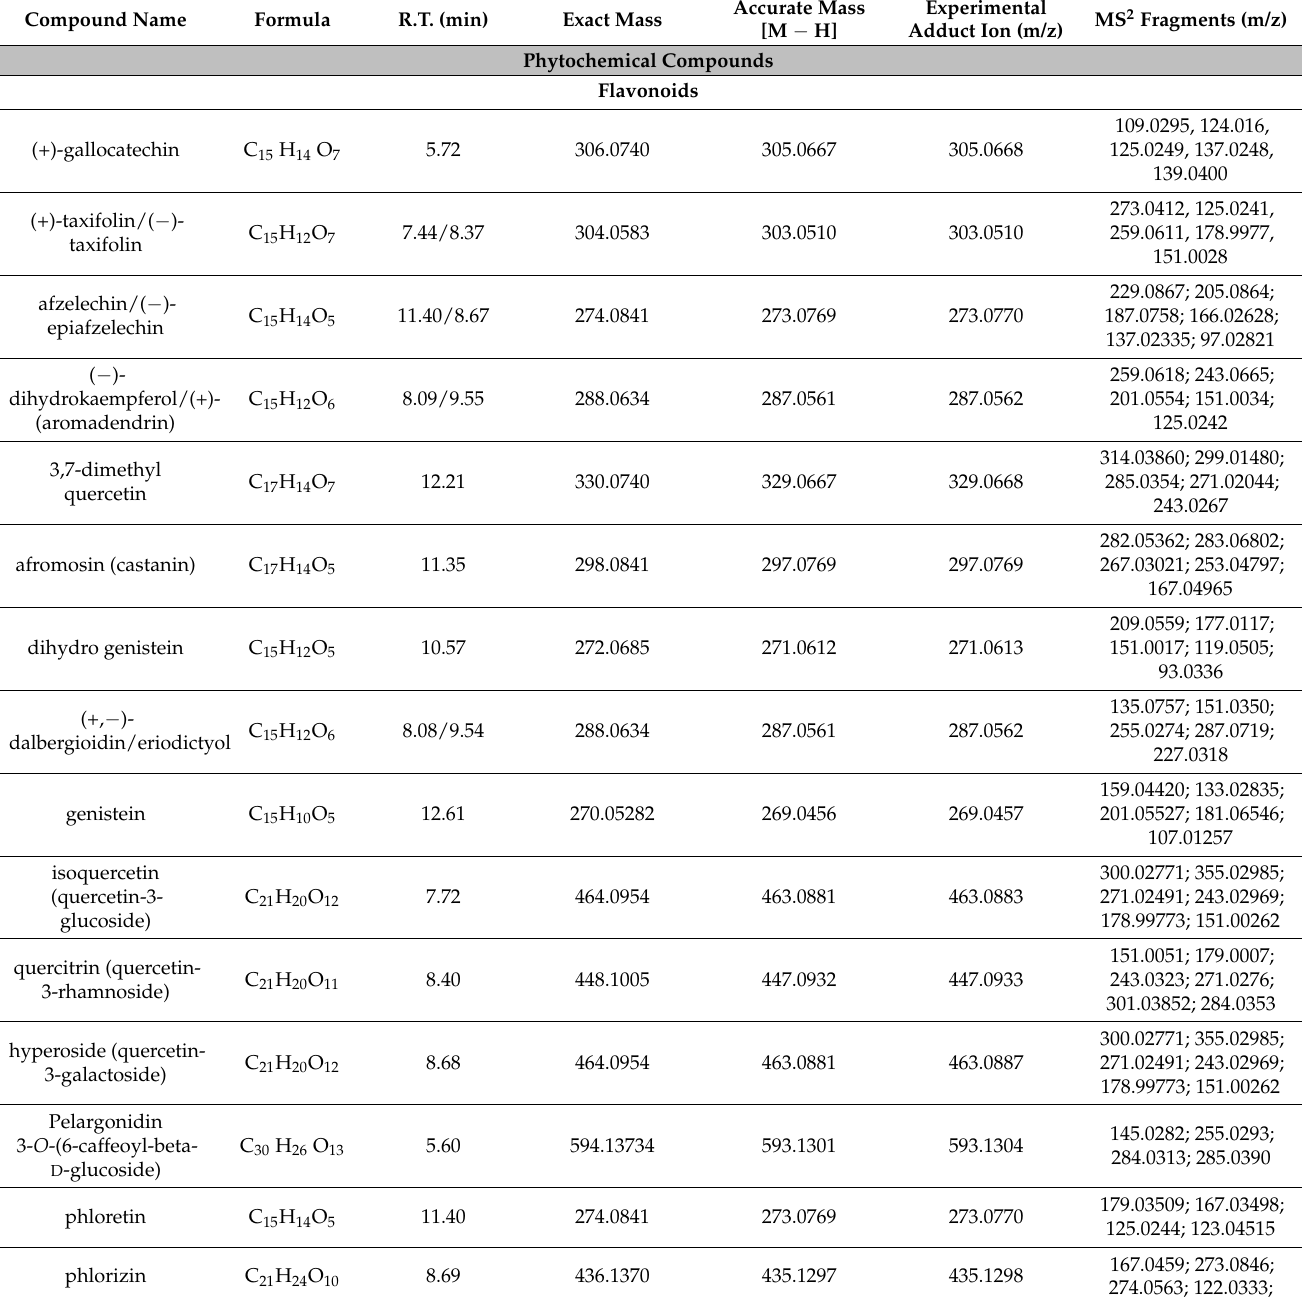
Table 3. Identification of bioactive phytochemical compounds (flavonoids, chalcones, terpenoids and sesquiterpenoids, gibberellin plant hormones), organic acids, amino acids and some nucleosides in chestnut extract by UHPLC-Q-Exactive high-accuracy analysis of deprotonated precursors and fragment ions of specific components combined with data processing using Compound Discoverer